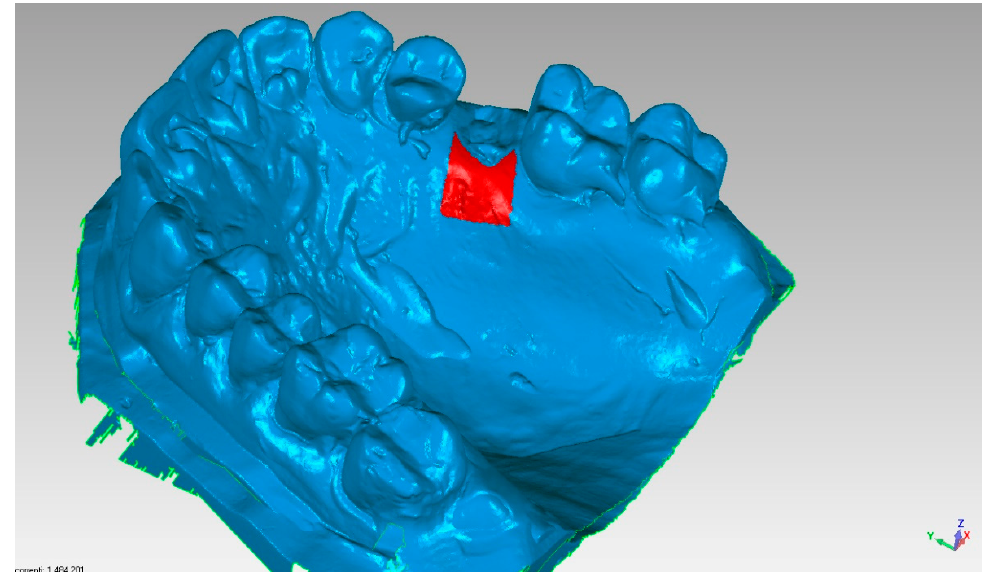
Figure 4. Area of analysis regarding palatal volume variations.